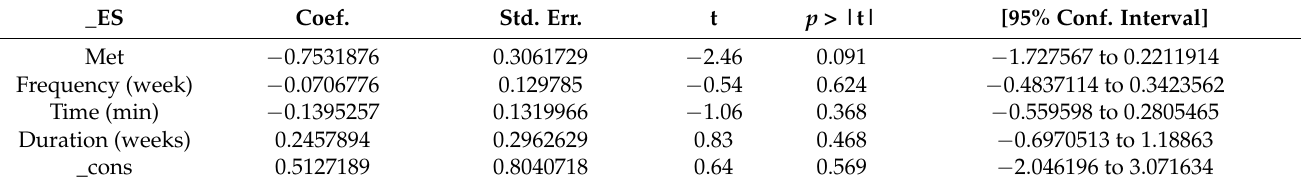
Table 4. Covariate Regression Analysis of Physical Activity on University Students’ Anxiety.